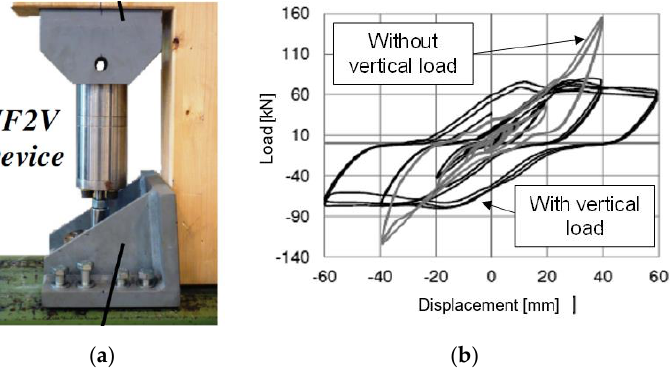
Figure 10. Damper-based HD: ( a ) close-up view of the damper device (photo credit: Geoffrey Rodg- ers, reprinted with permission); ( b ) typical load – displacement curve.